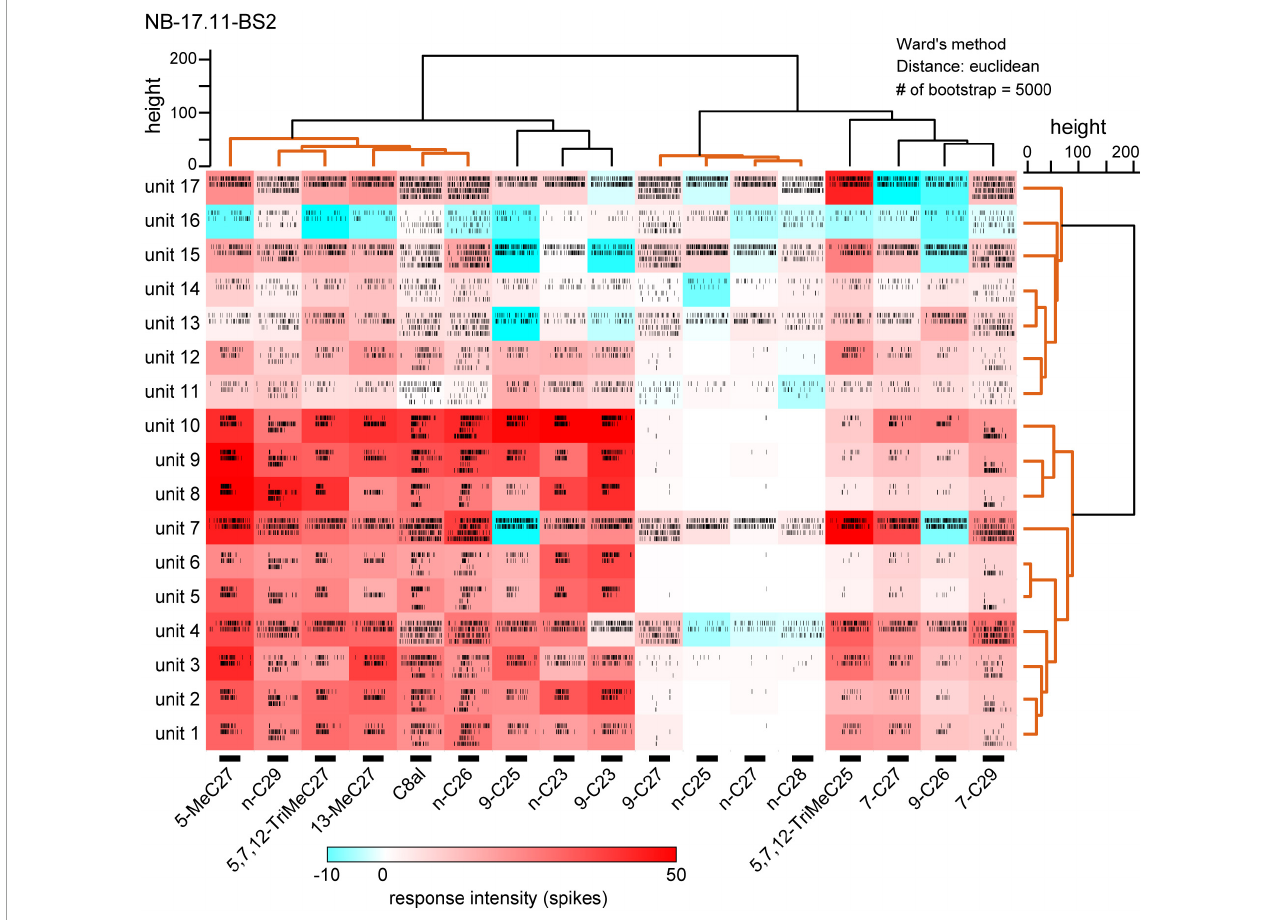
FIGURE4 Cuticular hydrocarbon (CHC) response spectra of 17 sorted SNs in a basiconic sensillum. We sorted spike units of 17 SNs (units 1–17) from the multi-unit recording of a basiconic sensillum (NB-17.11-BS2). Response intensities of each sorted SNs to 16 tested CHCs are shown as a heatmap. Each CHC was presented to an antenna two to four times, and temporal activity patterns of each sorted SN are shown as raster plots. The bars under the heatmap indicate the 2-s period of CHC stimulation. Using cluster analyses, we clustered sorted SNs based on the similarities of response spectra (the right dendrogram), and clustered tested CHCs based on the spatial activity patterns of SNs (the upper dendrogram). According to the bootstrap P -values ( > 0.90), we identified several groups of CHCs and SNs (orange lines in dendrograms). CHC responses in each of 23 basiconic sensilla were analyzed using the same method, and results of spike sorting and cluster analysis of CHCs are summarized in Table 2